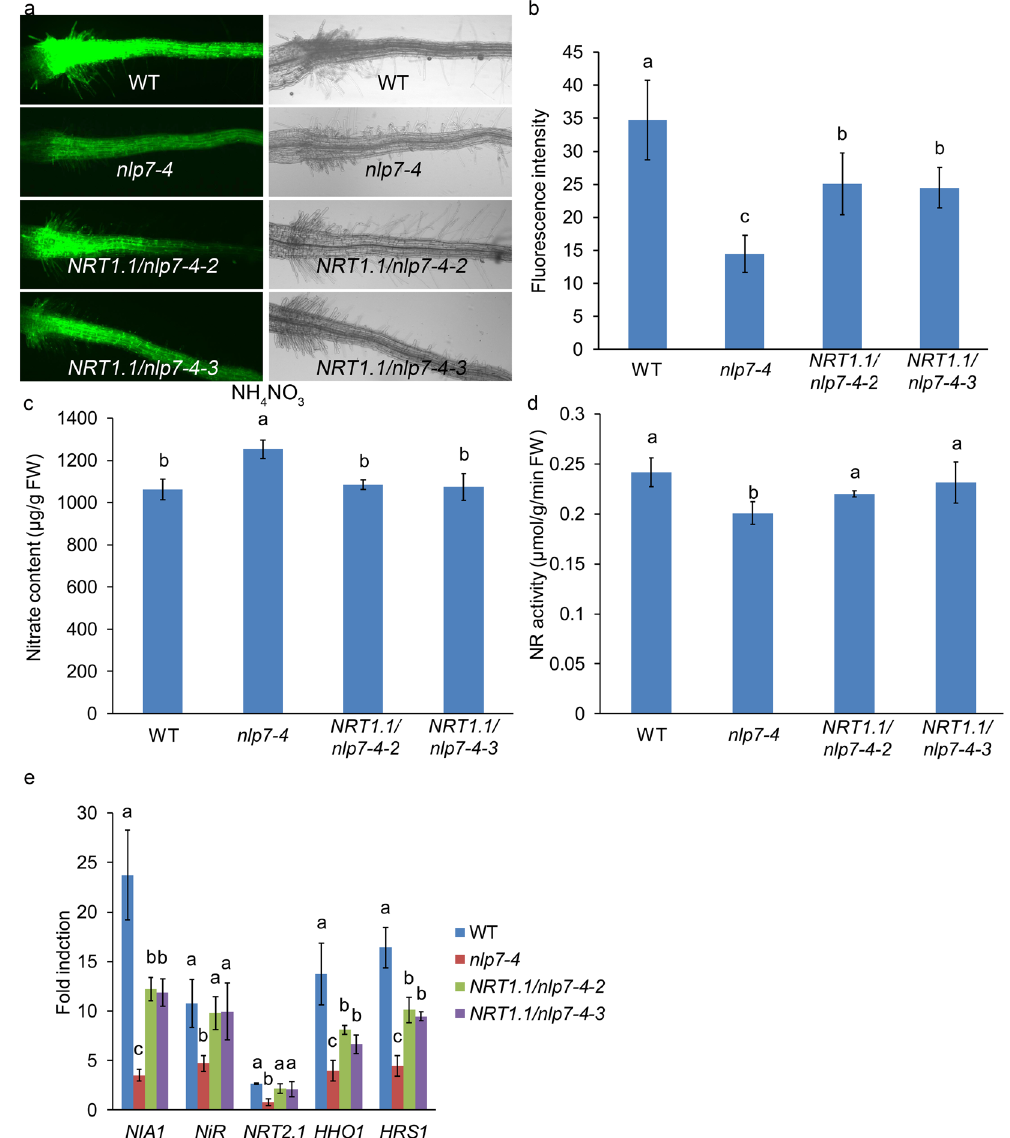
Figure 3. NRT1.1 can restore the phenotypes of nlp7-4 . ( a ) Root YFP observation of WT, nlp7-4 , and NRT1.1/ nlp7-4 plants. Fluorescence and light images of seedlings which grown on the medium with 10 mM ammonium nitrate for 5d were captured using a fluorescence microscope. ( b ) Quantification of root YFP signal levels of WT, nlp7-4 , and NRT1.1/nlp7-4 plants. The same conditions for plants growth were used as ( a ). Error bars mean ± SD of sixty biological replicates. The significant difference ( p < 0.05, t test) is indicated by different letters. ( c ) Nitrate content in WT, nlp7-4 , and NRT1.1/nlp7-4 plants. The 7-d-old seedlings on the medium with 10 mM ammonium nitrate were used for nitrate content detection. Error bars mean ± SD of four biological replicates. The significant difference ( p < 0.05, t test) is indicated by different letters. FW, fresh weight. ( d ) Nitrate reductase activity in WT, nlp7-4 , and NRT1.1/nlp7-4 plants. The growth conditions are the same as ( c ). Error bars mean ± SD of four biological replicates. The significant difference ( p < 0.05, t test) is indicated by different letters. FW, fresh weight. ( e ) The induction of endogenous genes after nitrate treatment in WT, nlp7-4 , and NRT1.1/nlp7-4 plants. Seedlings grown on 2.5 mM ammonium succinate medium for 7d were treated with 10 mM KNO 3 or KCl for 2 h. Roots were used for detecting the expression of nitrate inducible genes by qPCR. Error bars mean ± SD of four biological replicates. The significant difference ( p < 0.05, t test) is indicated by different